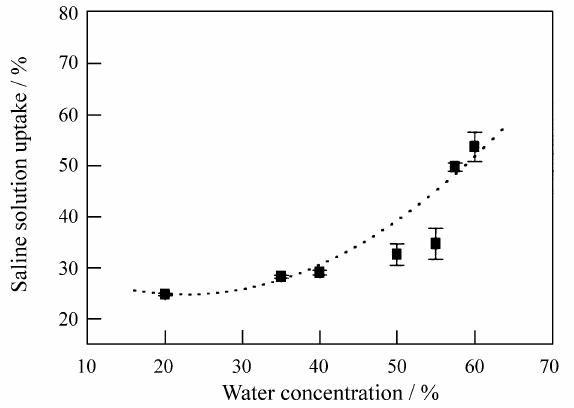
Figure 5. Saline solution uptake of polyHEMA obtained by solution polymerization using different amount of water as diluent.